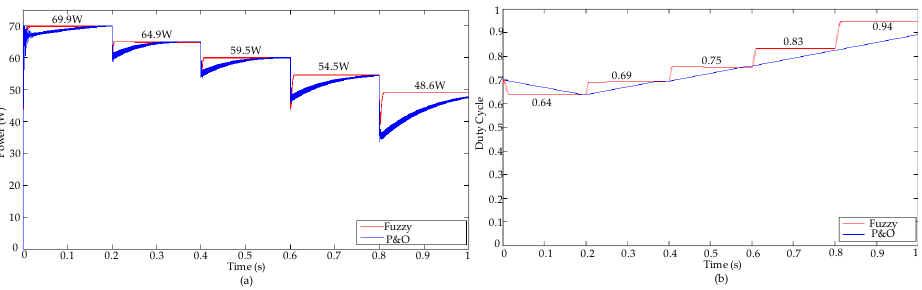
Figure 19. ( a ) Output power of the PV module para increases in temperature; ( b ) Duty cycle.